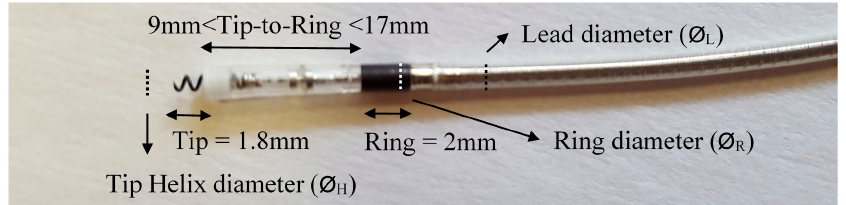
Figure 2. Active fixation pacemaker lead and its parts : Lead diameter (Ø L ), Ring length (constant = 2 mm) and diameter (Ø R ), tip to ring distance(9 mm to 17 mm), tip length (constant,1.8 mm), and tip helix diameter (Ø H ). Table 4. 10 different active fixation lead models from five different trademarks, including two leads per manufacturer.